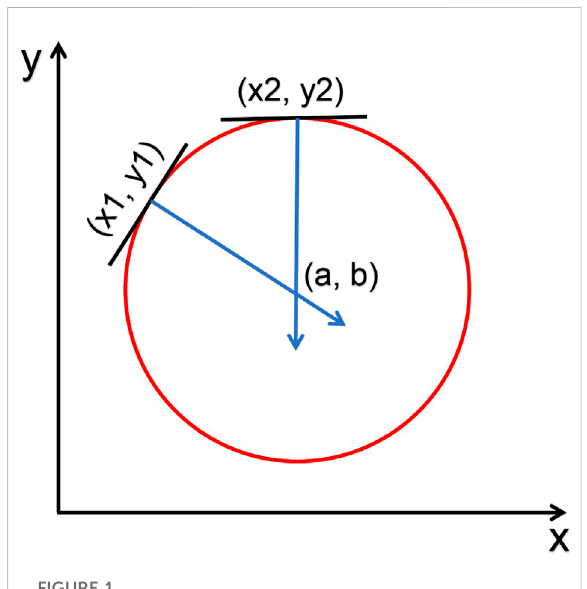
FIGURE 1 Schematic diagram of solar disk center